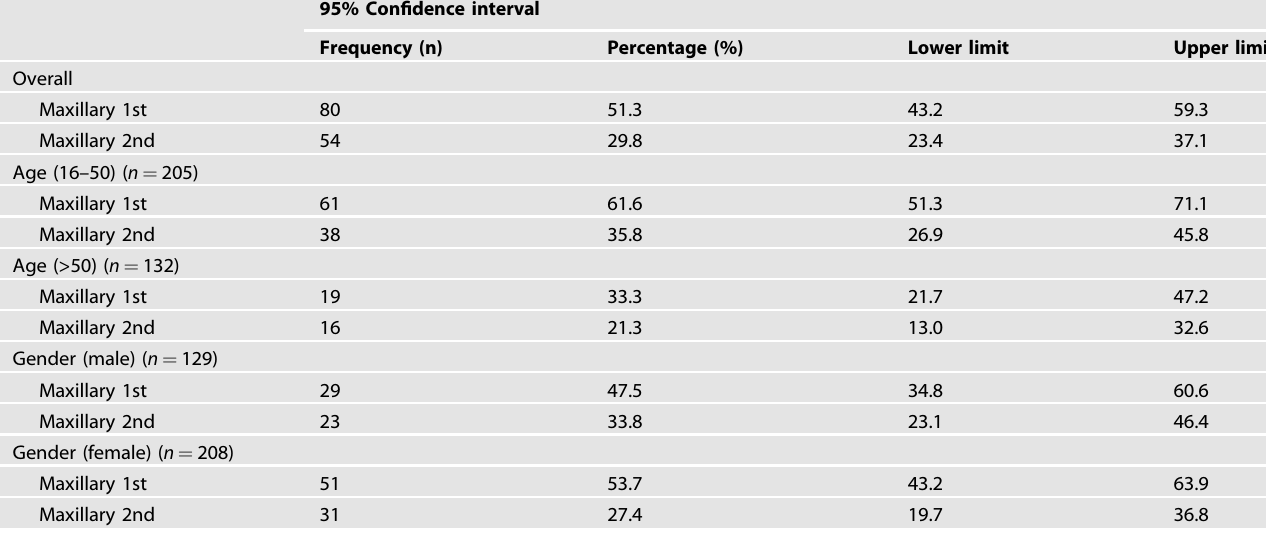
Table 1. The prevalence of MB-2 canals in maxillary fi rst and second molars by overall, gender and age groups ( n = 337).